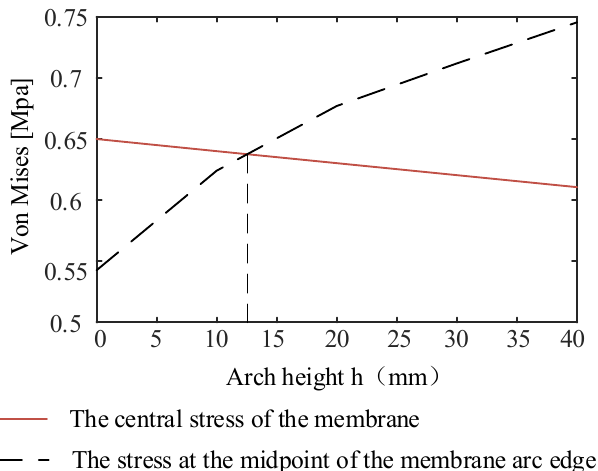
the center point of the membrane is equal to the stress at the center point of the arc edge, the overall minimum stress of the membrane is enhanced to the greatest extent. At this time, the highest stiffness is obtained in the whole membrane plane. The trend of stress at the center point of the membrane and the trend of stress at the center point of the arc edge are obtained by the SSM, as shown in Figure 9.